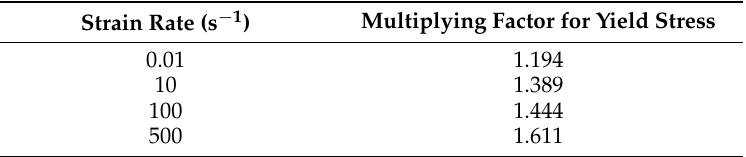
Table 1. Multiplying factor for yield stress as a function of strain rate. Strain Rate (s ´ 1